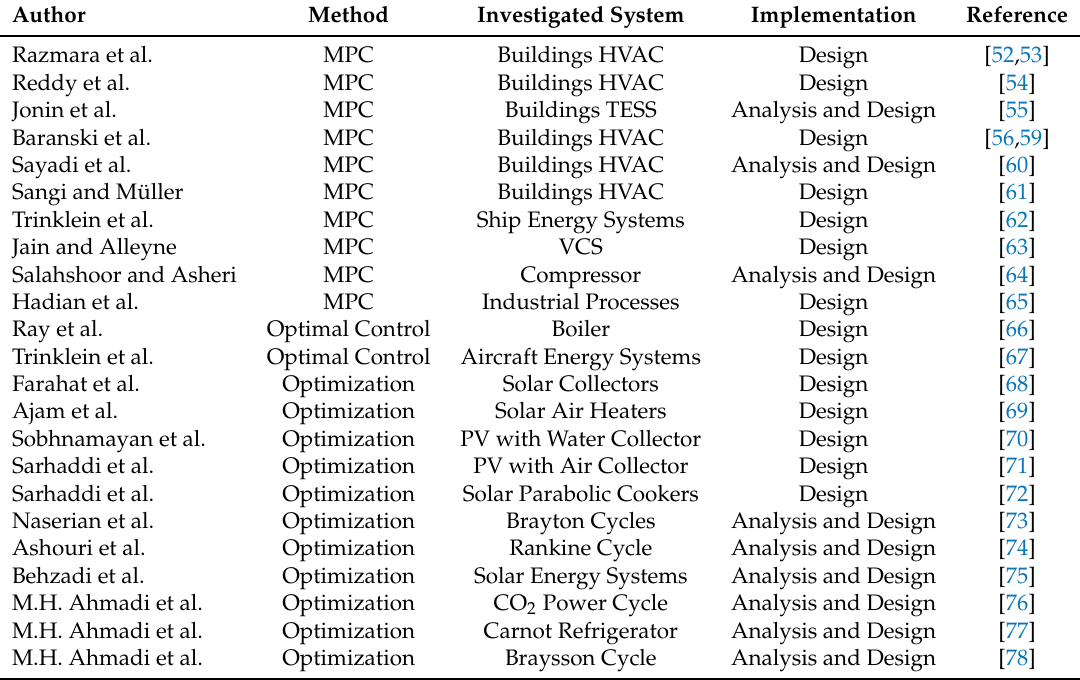
Table 1. Summary of works related to exergy based optimization and